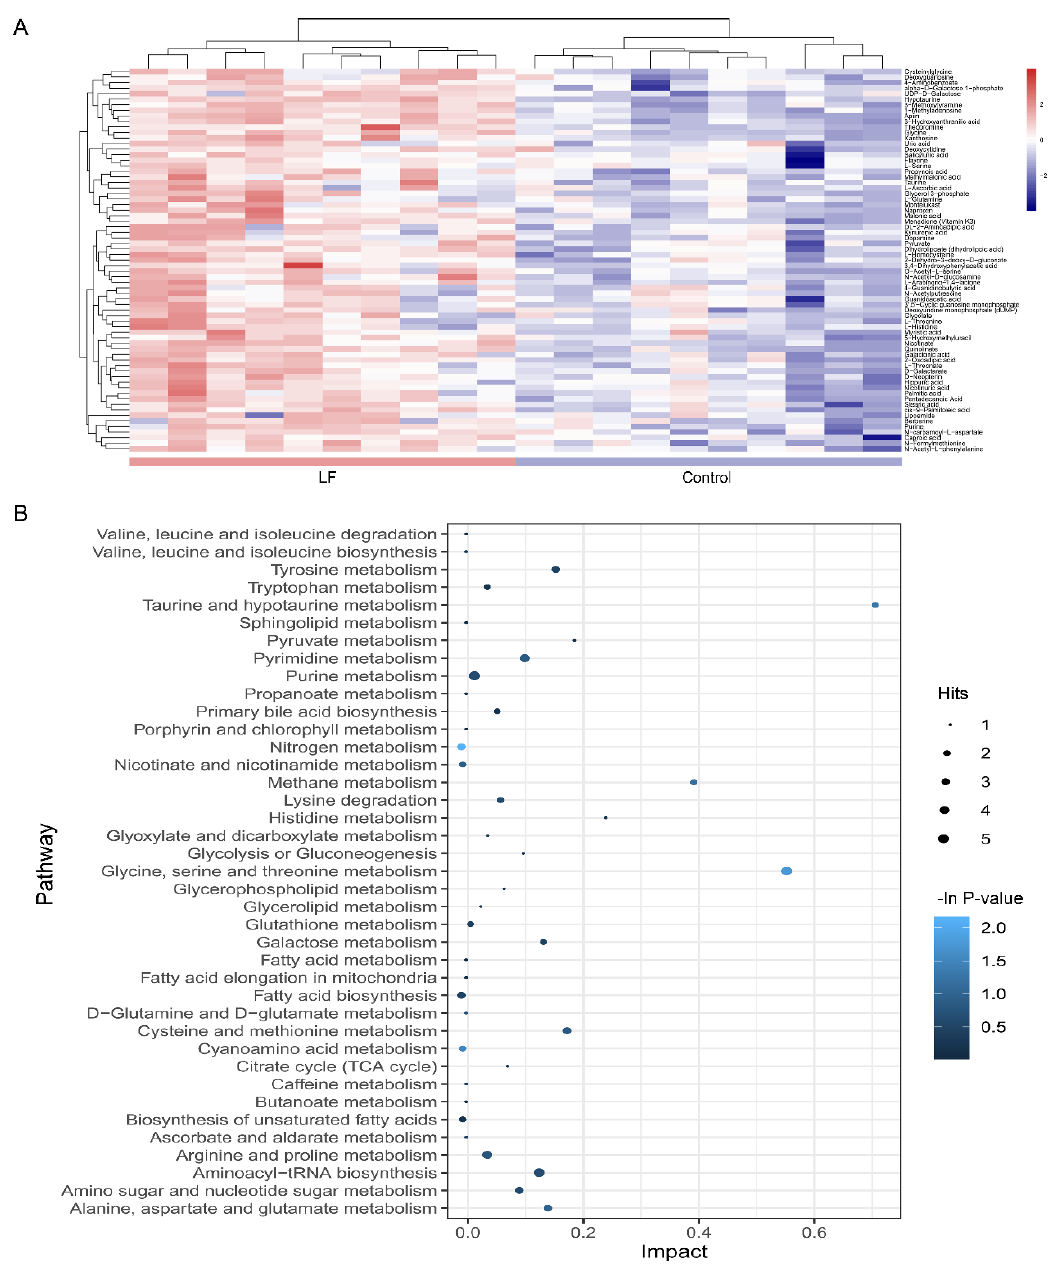
Figure 4. Metabolic pathway affected by LF supplementation. ( A ) Heatmap shows different expression levels of the 69 significantly altered metabolites in urine between the control and lactoferrin groups. Color range from blue to red represents metabolite level from low to high. ( B ) Bubble plot displays metabolic pathway enrichment analysis of the 69 significantly altered metabolites by LF supplementation. Node size is proportional with number of metabolites in given pathway and based on hits of each identified metabolite in a given pathway. Node color is graded according to its P-value in the pathway enrichment analysis.